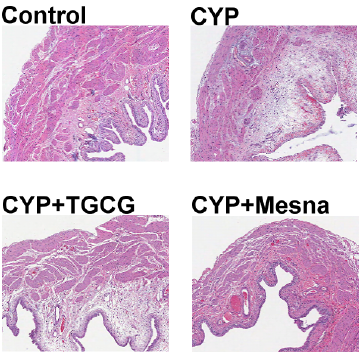
Figure 2. Average weight of bladders between group 1—saline-injected control, group 2—CYP + placebo with normal saline, group 3—CYP + TGCG (200 mg/kg), and group 4—CYP + Mesna (30 mg/kg). Each bar in the figure denotes the mean ± standard deviation. * p < 0.05 contrasted to control group. # p < 0.05 compared to CYP.